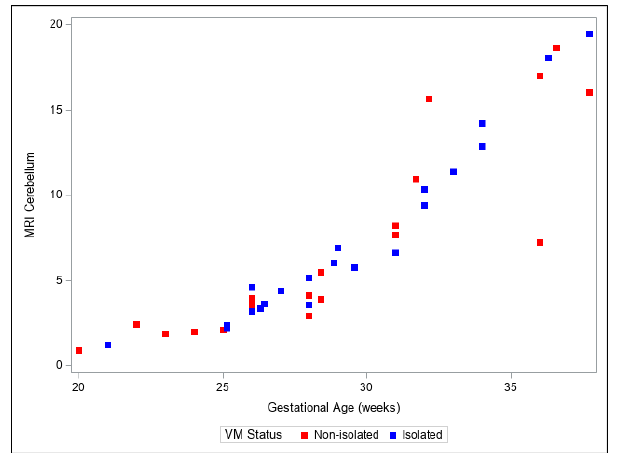
Figure 7. Three-dimensional growth trajectory measurements of cerebellar hemisphere volume in isolated and non-isolated VM.